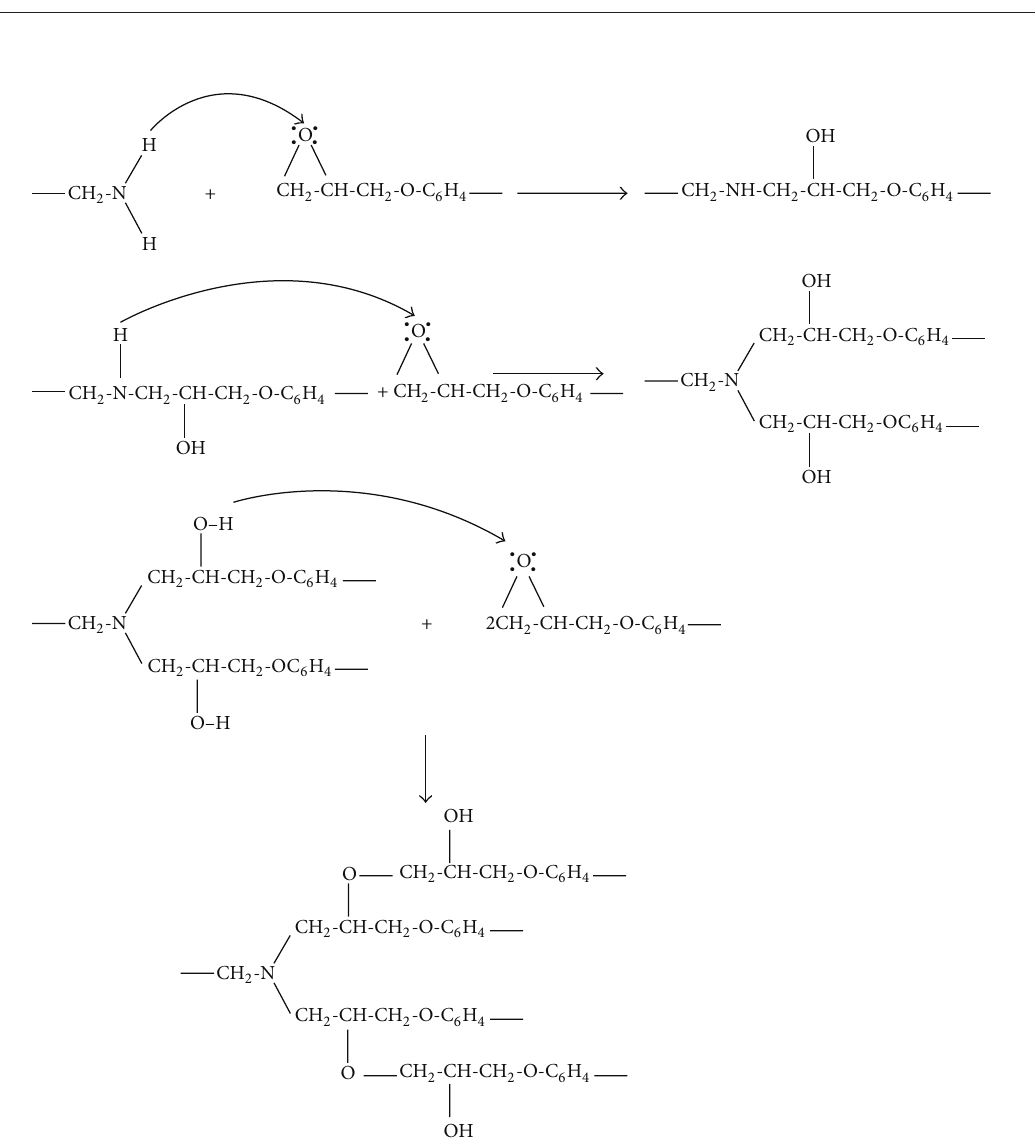
Scheme 3: Reaction between epoxy resin and